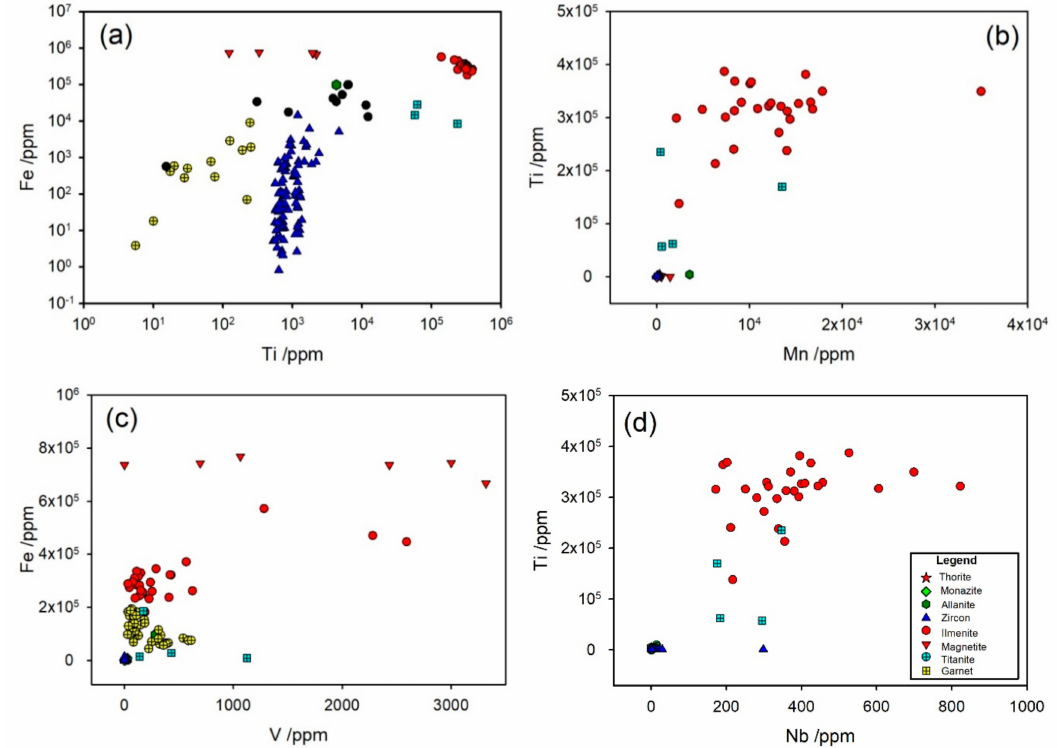
Figure 9. Mineral analysis (where ilmenite, magnetite, and titanite have the highest concentrations of the elements represented in the plots) with correlation between ( a ) Ti and Fe; ( b ) Mn and Ti; ( c ) V and Fe, and ( d ) Nb and Ti. The legend applies to all plots in this